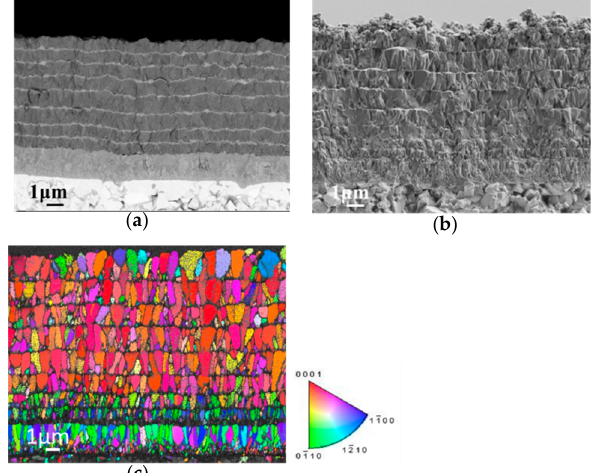
Figure 1. Cross-section SEM micrographs of α -Al 2 O 3 multilayer coatings. ( a ) Back-scatter SEM image of the coating deposited at CO 2 = 4 vol %, ( b ) Bright-field SEM image of the coating deposited at CO 2 = 6 vol % and ( c ) Cross-section EBSD IPF map of the coating deposited at CO 2 = 6 vol %.